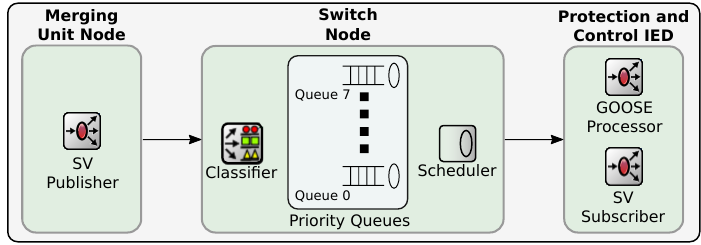
Figure 6. Main developed simulation models.